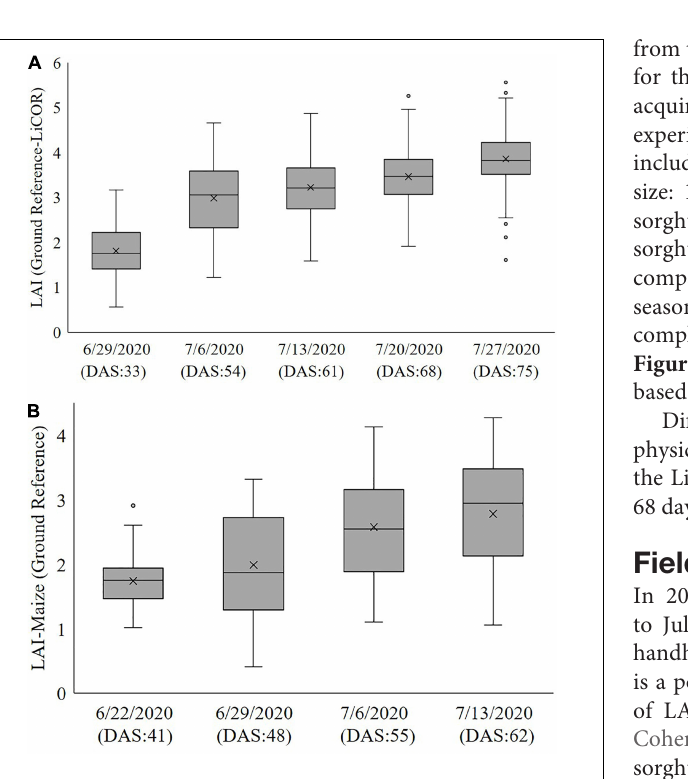
this study, near concurrent ground-based and UAV LiDAR data were analyzed. The LiDAR data were collected from the Sorghum Biodiversity Test Cross Calibration Panel (SbDivTc_Cal) and the maize High-Intensity Phenotyping Sites (HIPS) Panel. The SbDivTc_Cal experimental design included 80 varieties two replicates in a randomized block design planted in 160 plots (plot size: 7.6 m × 3.8 m), ten rows per plot (row number is